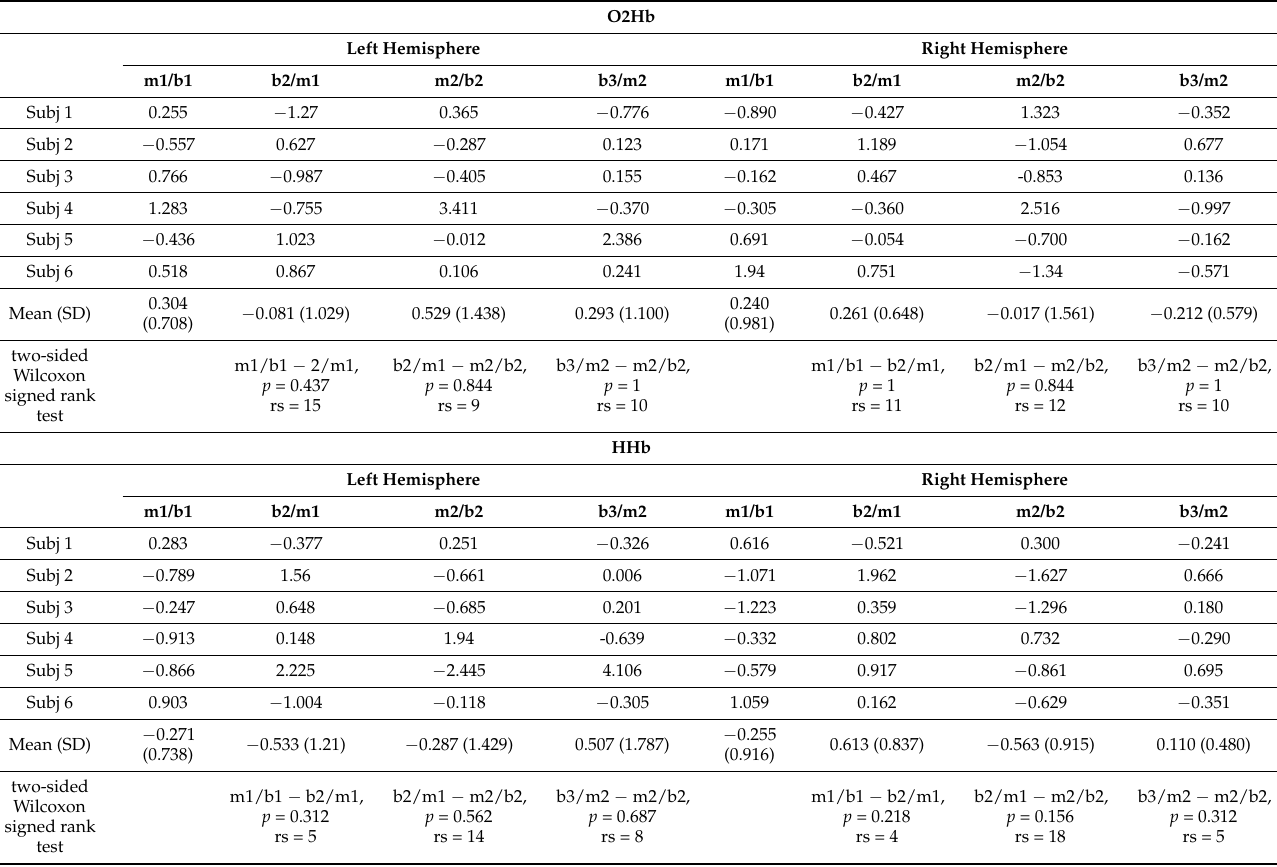
Table 3. VLFO.Ratio (low-frequency oscillation) between the subsequent pairs of experimental blocks, for O2Hb (top) and HHb (bottom), for the left hemisphere (left column) and the right hemisphere (right column). Pairwise comparison between VLFO.Ratio obtained in subsequent pairs of experimental blocks was performed with Wilcoxon signed rank test. (m1/b1) from baseline to the first music block; (b2/m1) from the first music block to the second baseline (m2/b2) from the second baseline to the second music block; (b3/m2) from the second music block to the third baseline. Rs = rank statistic. O2Hb Left Hemisphere Right Hemisphere